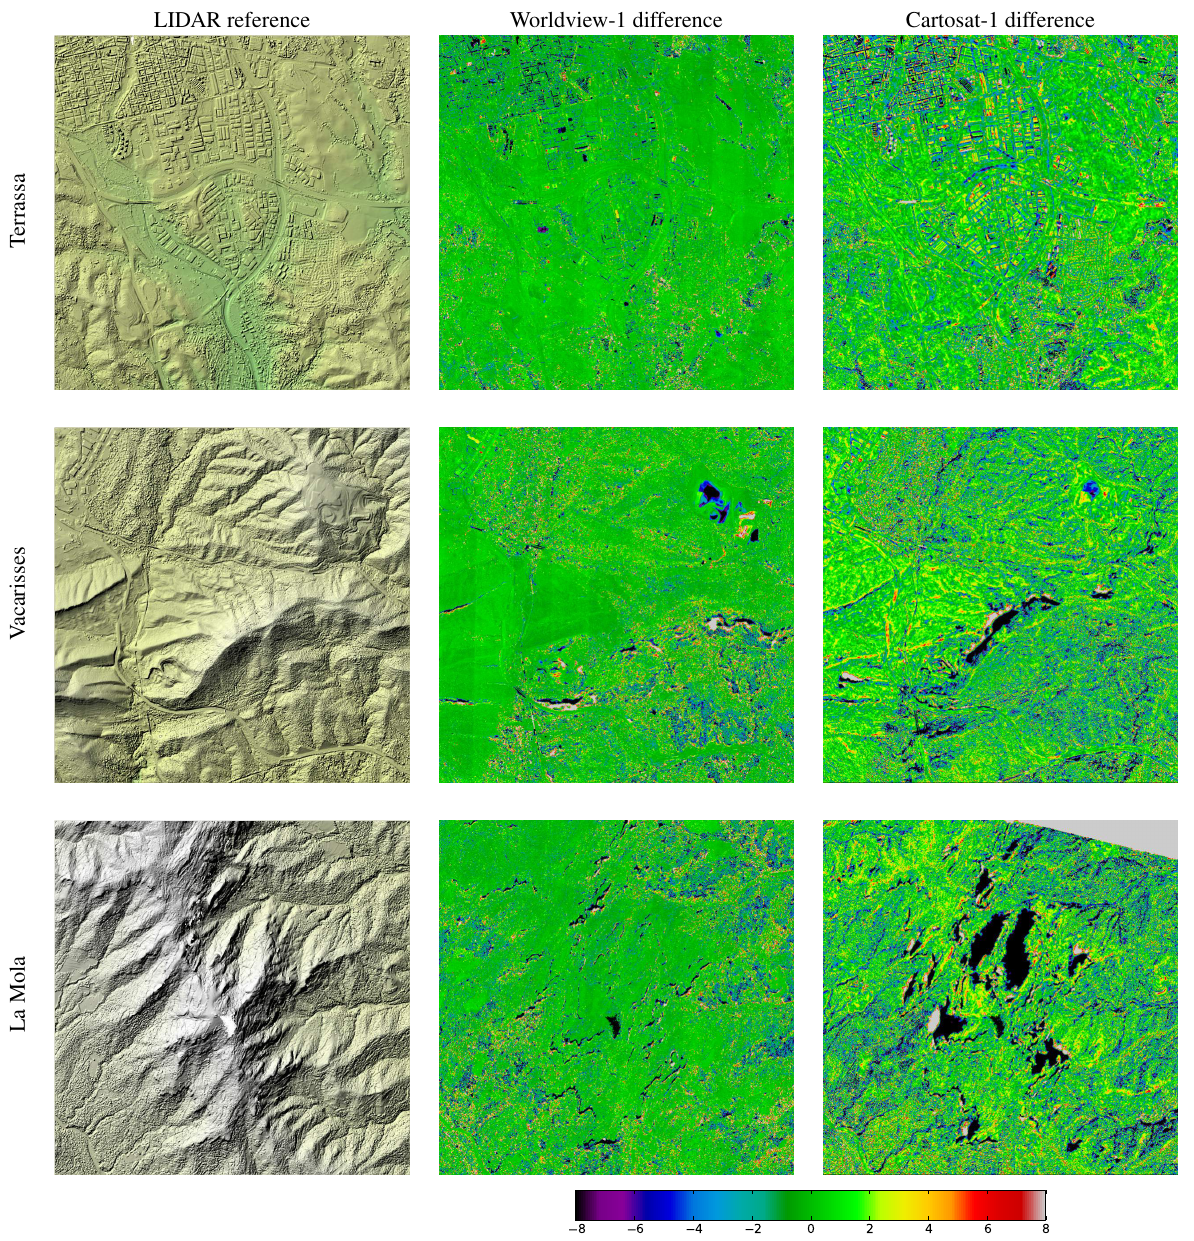
Figure 5: Results on for the test areas. The shaded reference LIDAR DSM is shown in the first column. The second and third column show the euclidean distance between the LIDAR points and the Worldview-1 and Cartosat-1 DSMs. Areas with positive distance (yellow, red) are located below the LIDAR surface, blue and black areas are located above the reference. Most errors in the Terrassa area are located in the densly build up city area. The larger industrial buildings are reconstructed relatively well in the WV-1 DSM. The waste dump located in the the north east corner of the Vacarisses area did change significantly, this change was masked out during the statistical evaluation. Both Wordview-1 and Cartosat-1 show some errors on the mountain ridges. Problematic areas in the Cartosat-1 DSM include the large shadows and parts of the highway network. The La Mola area is challenging, as steep cliffs and large shadows result in DSM errors, particularly for